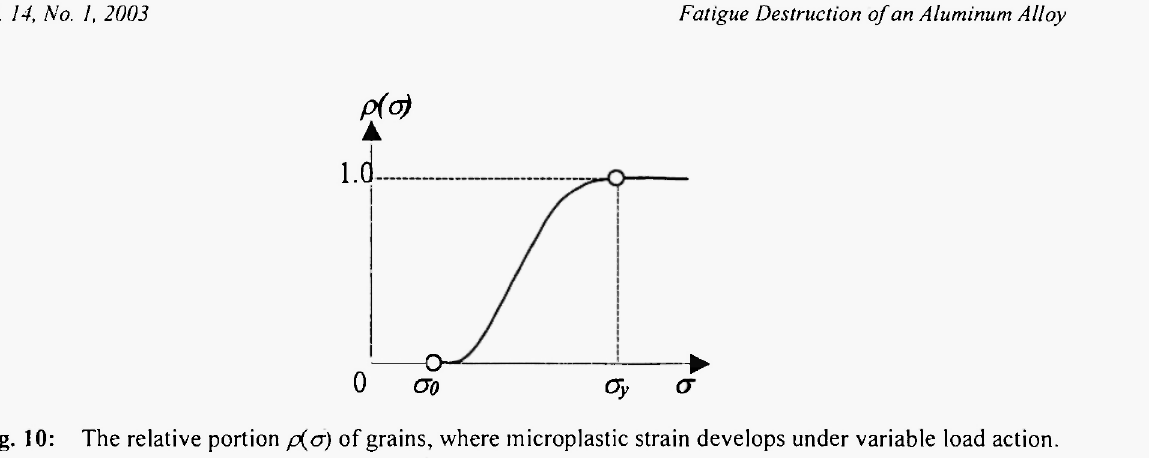
Fig. 10: The relative portion ρ(σ) of grains, where microplastic strain develops under variable load action.